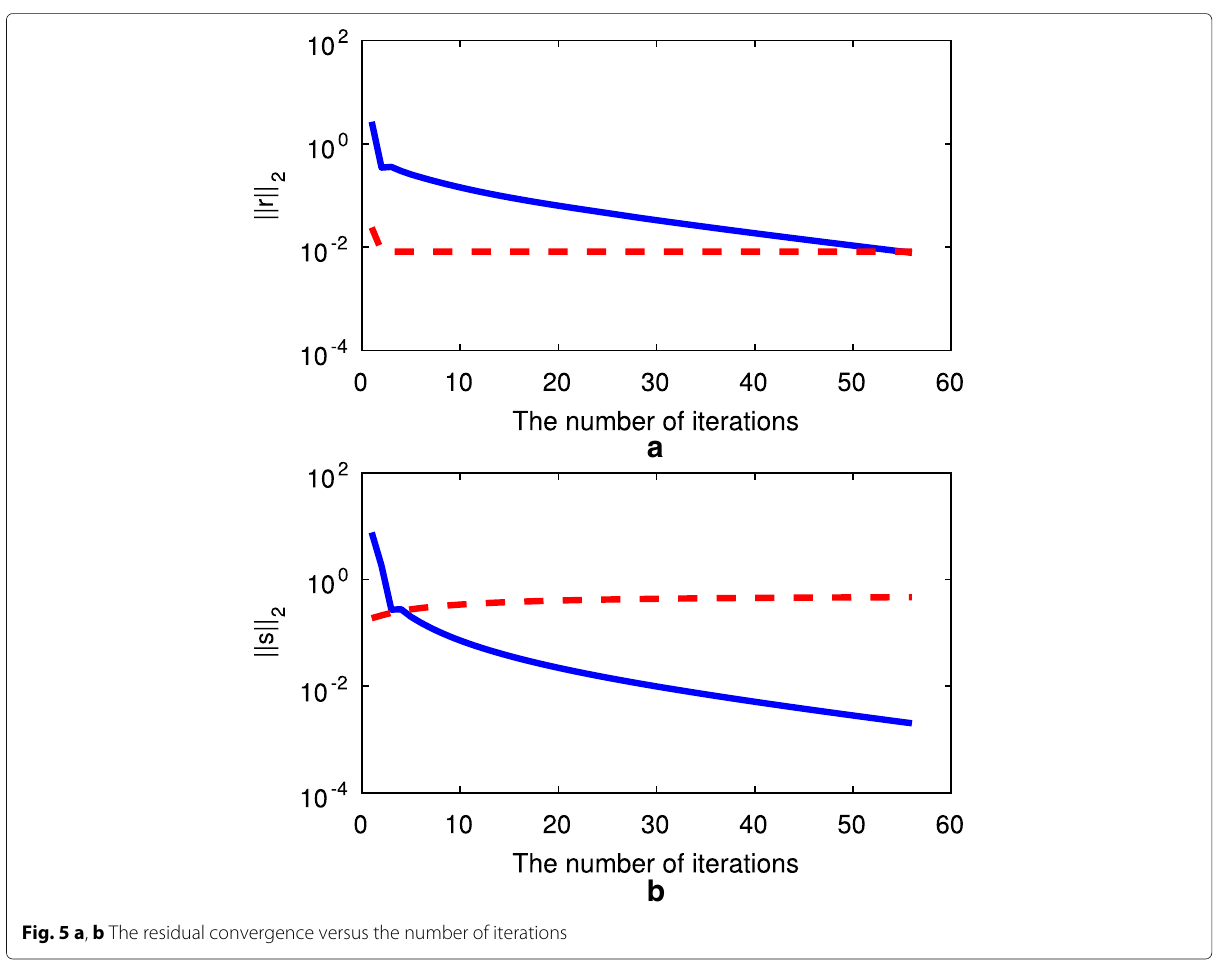
Fig. 5 a , b The residual convergence versus the number of iterations